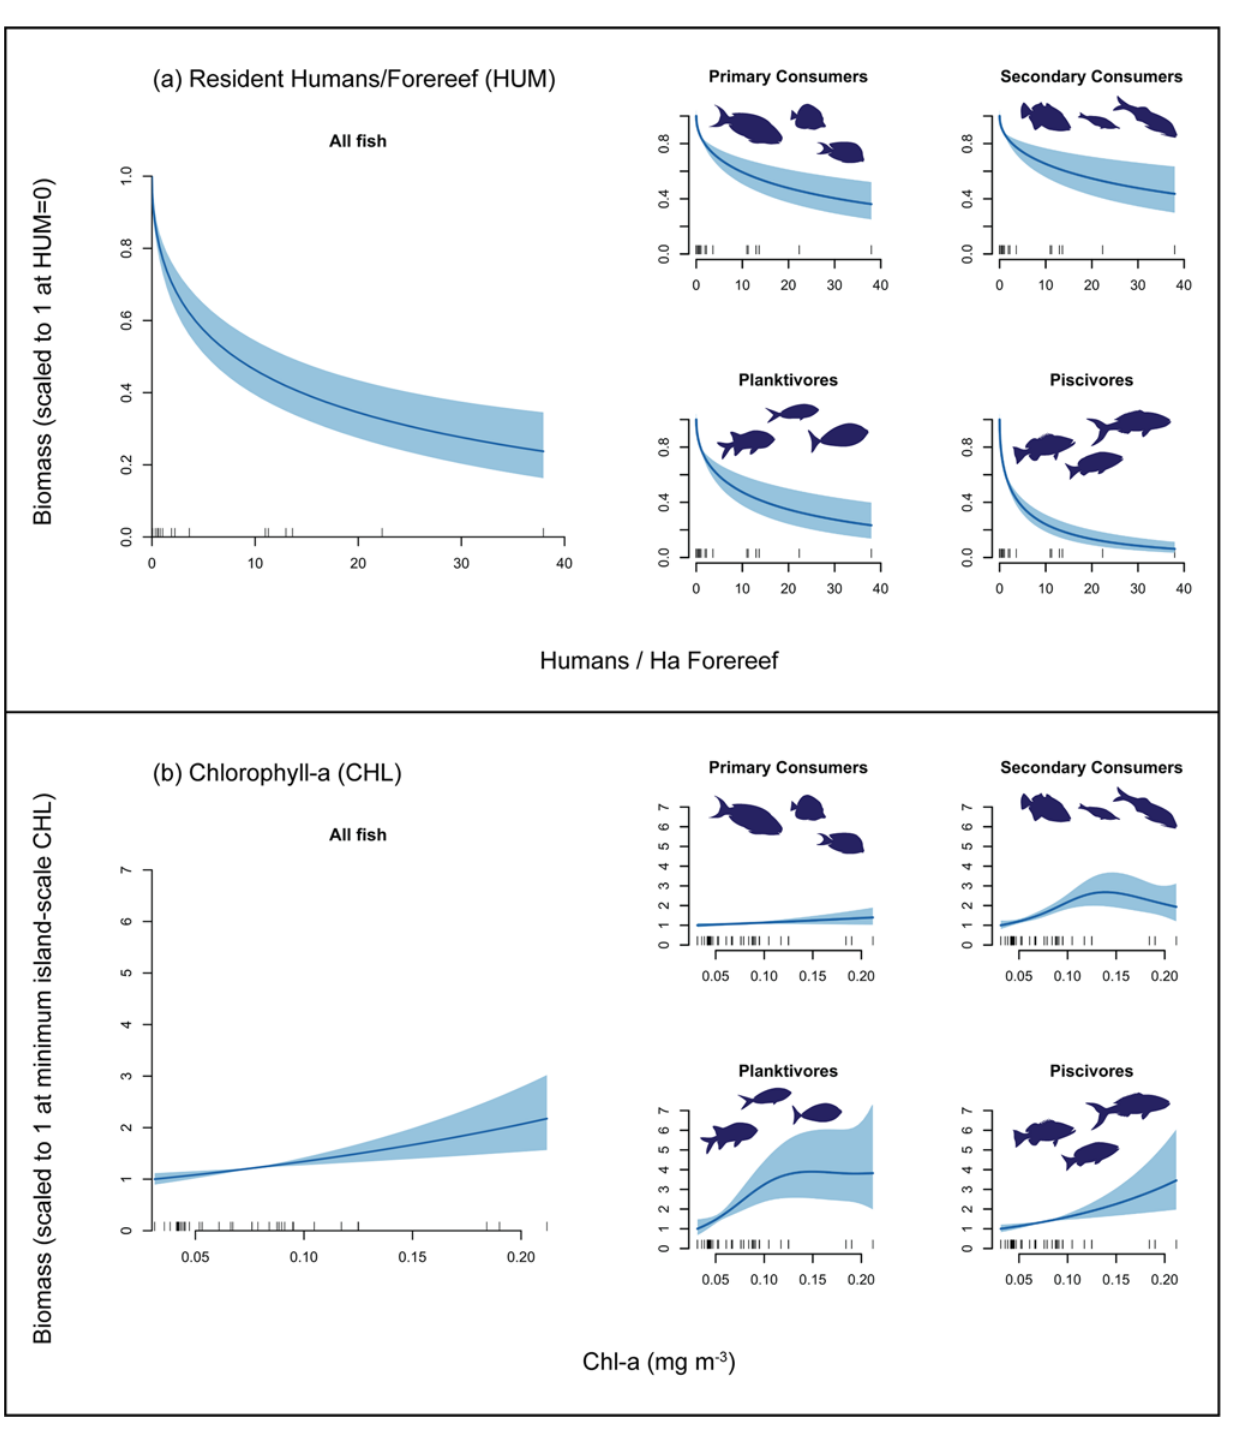
Fig 3. Mean susceptibility values and standard error in major veins. * indicates statistically significant difference between controls and